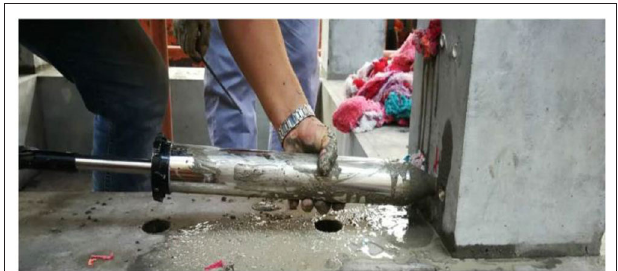
Frontiers in Materials |